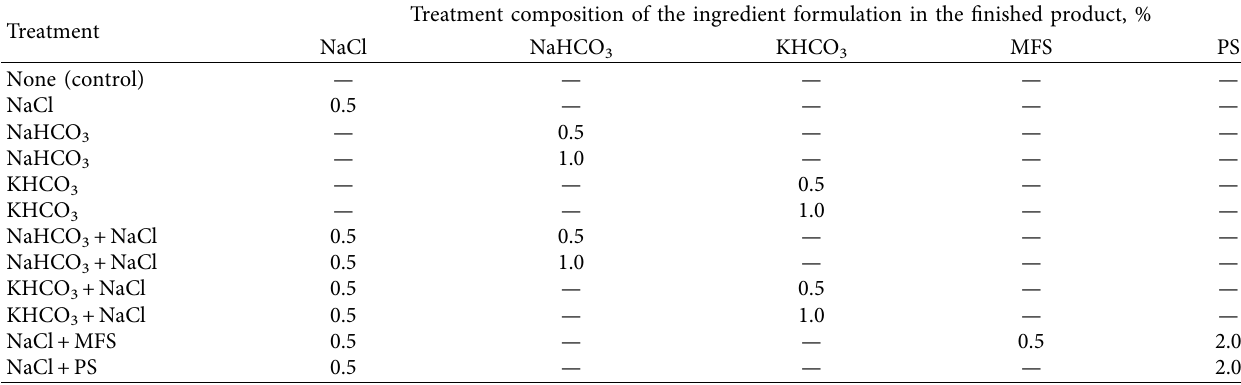
Table 1: Mixture formulations for ground beef treated with different levels of sodium bicarbonate, potassium bicarbonate, salt, modified food starch, and potato